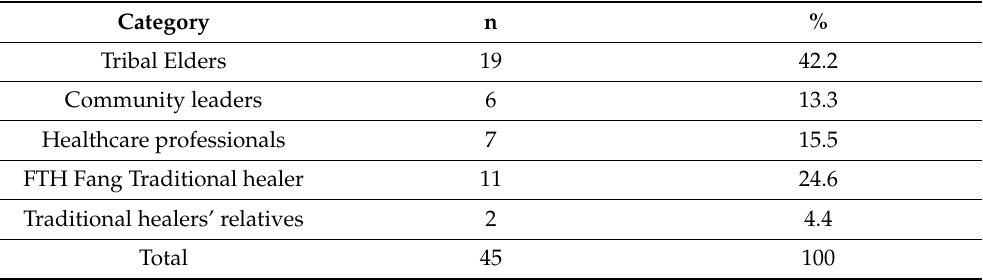
Table 1. Categories of participants (n = 45). Category n % Tribal